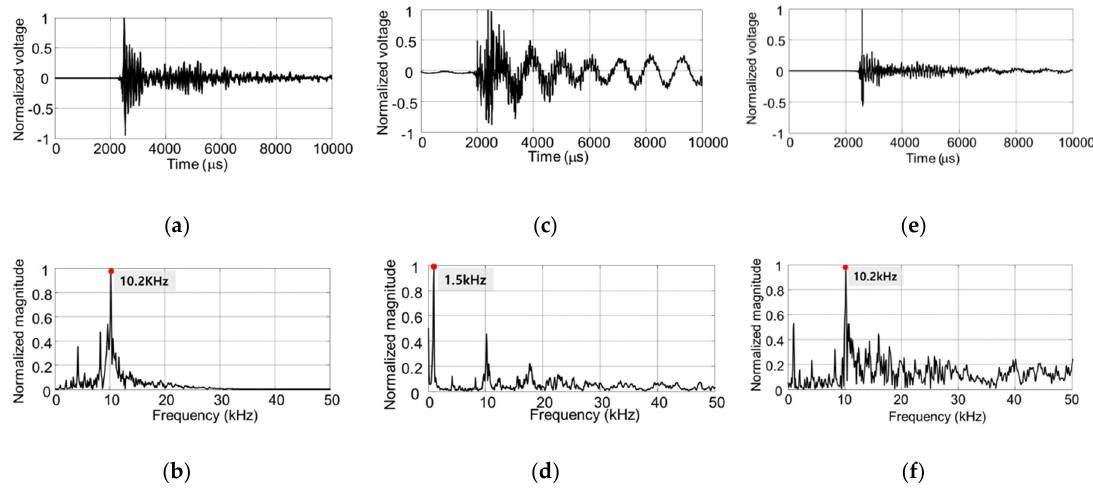
Figure 8. Obtained signals from the deep delamination. Steel ball impactor ( a ) time signal and ( b ) frequency spectrum. 11-tooth gear ( c ) time signal and ( d ) frequency spectrum. 30-tooth gear ( e ) time signal and ( f ) frequency spectrum.